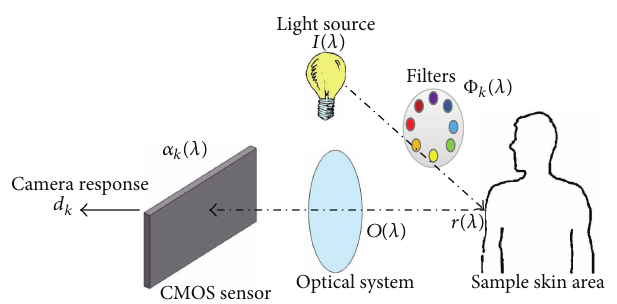
Figure 4: Synopsis of the spectral model of the acquisition process in a multispectral imaging system. The decomposition of the spectral model aims to retrieve only the skin reflectance spectrum 𝑟(𝜆)